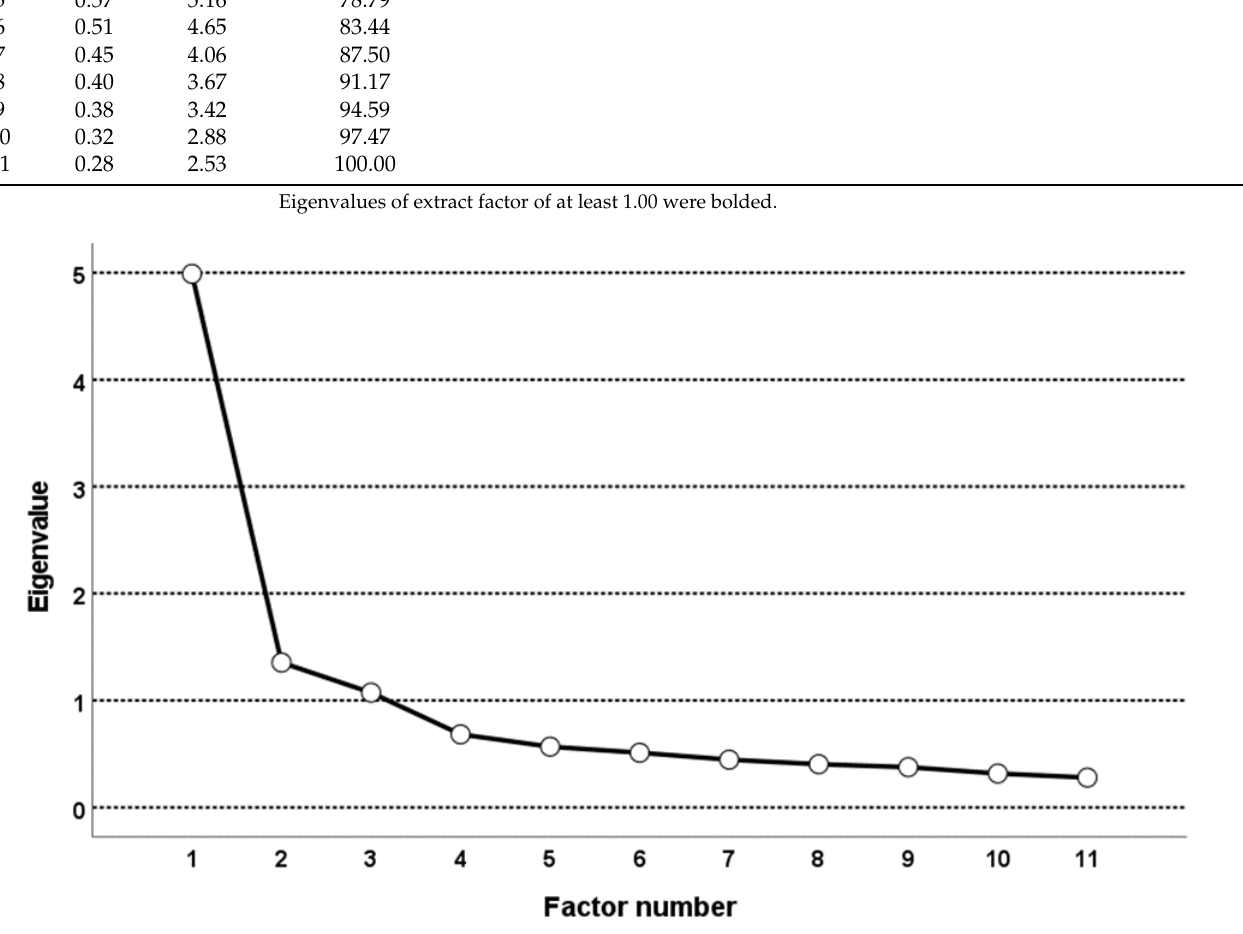
Figure 1. Scree plot.